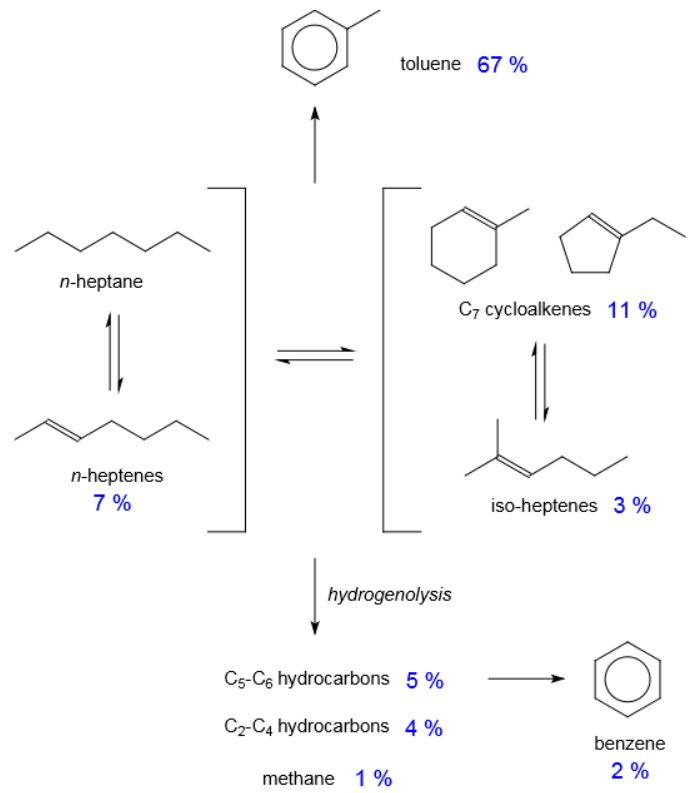
Figure 9. Reaction network of catalysis over Pt/K/LTL illustrated with selectivity values obtained at 86% n -heptane conversion at 500 °C, near atmospheric pressure, weight hourly space velocity of 0.68 h − 1 and C 7 :H 2 feed rate of 1:6.